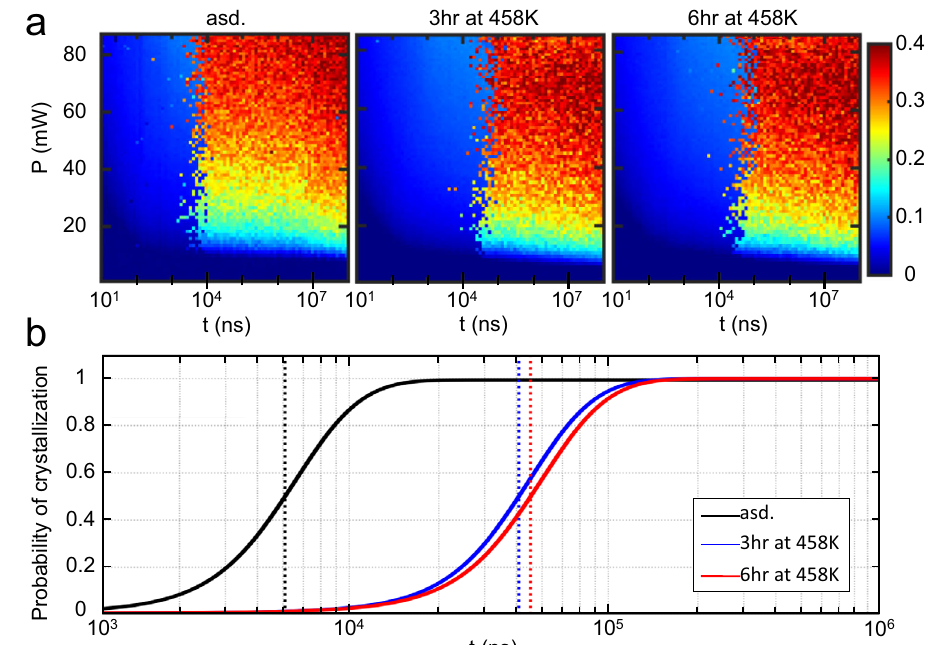
Fig. 2 | Crystallization time as a function of laser pulse duration for the as- deposited, 3 and 6h annealed Ge 15 Sb 85 fi lms. a Power-time-effects (PTE) dia- grams of the as-deposited,3 and 6h annealedGe 15 Sb 85 thin fi lms. The x -axis and y - axis represent the pulse duration t (ns) and power P (mW), respectively. The re fl ectance contrast Δ R is encoded in the color bar. b The probability of crystal- lization as a function of pulse duration during a fi ne pulse duration scan at a